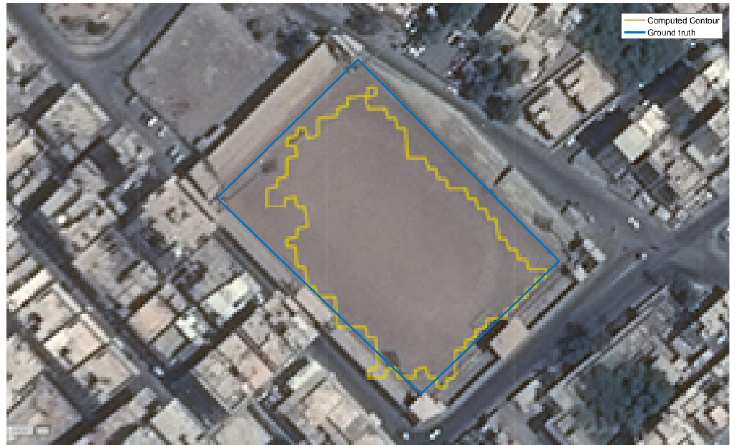
Figure 15. The region-based error between the algorithm’s boundary (A) and the ground truth boundary (B).